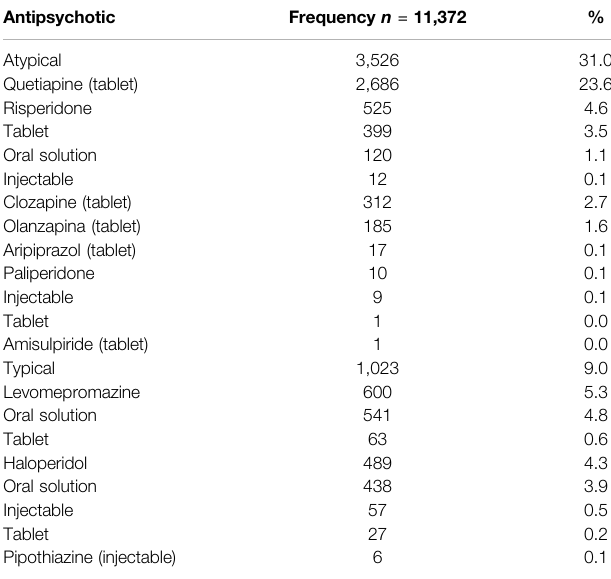
TABLE 1 | Antipsychotics prescriptions for a group of patients with dementia in Colombia, 2019.